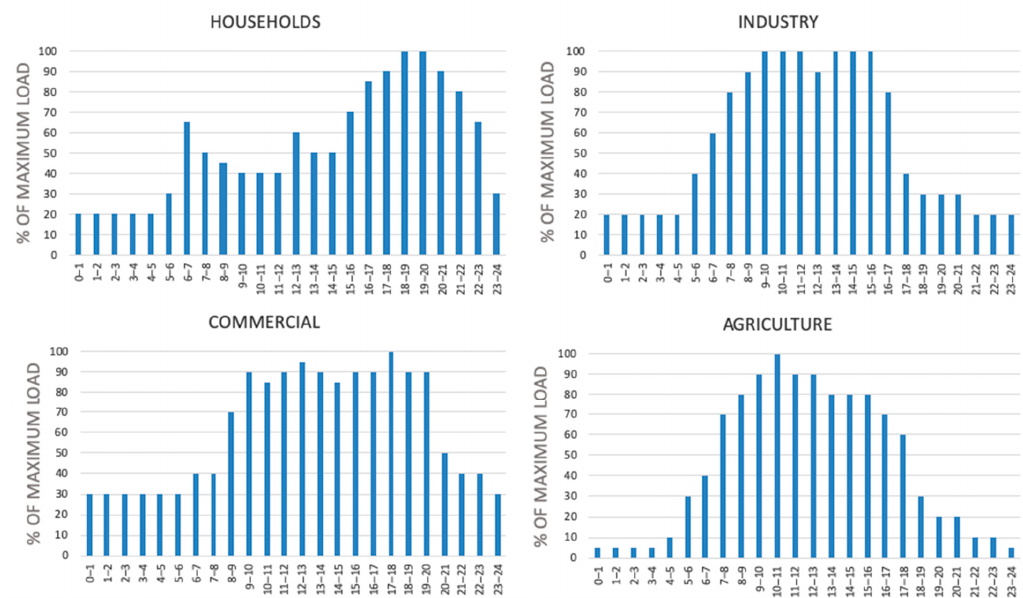
Figure 2. The daily and weekly electricity demand and production in Isla de la Juventud in January and July 2019. Data source: [43]. Figure 3 illustrates the typical weekday with sectoral electricity consumption as per- centages of the maximum sectoral load in January 2019. In general, the highest sectoral shares originate from the household sector in the total electricity consumption with the highest consumption taking place in the evenings (16:00–22:00).